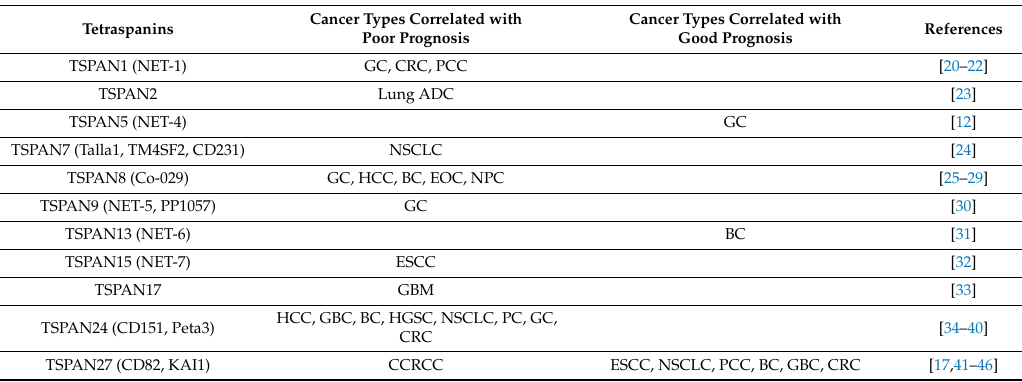
Table 1. Correlation between tetraspanins and clinical prognosis in human cancers. Tetraspanins Cancer Types Correlated with Poor Prognosis Cancer Types Correlated with Good